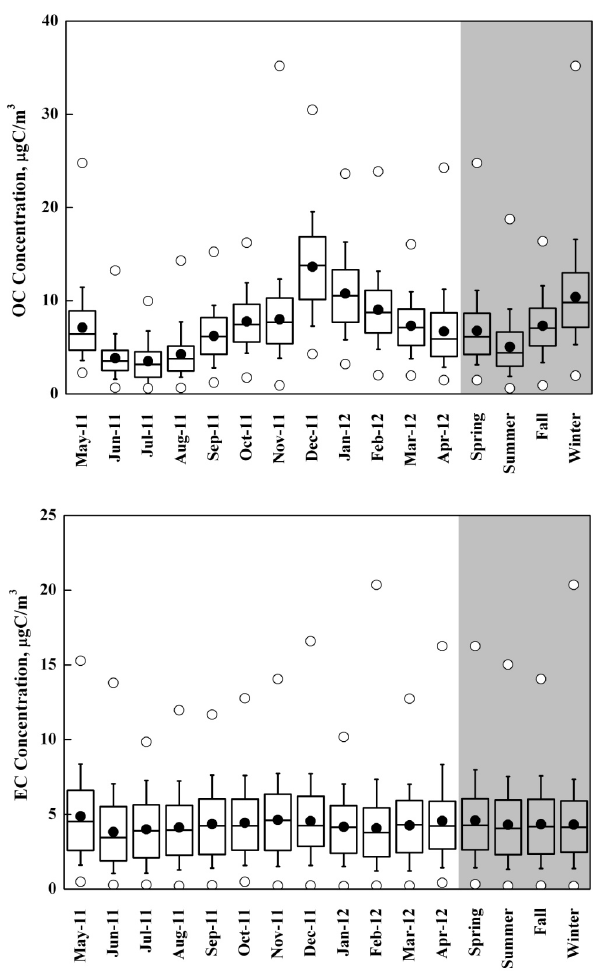
Figure 2 . The 1-hr OC and EC concentrations in individual sampling months and in different Figure 2. The 1h OC and EC concentrations in individual sampling months and in different seasons at MK AQMS during the study pe- seasons at MK AQMS during the study period from May 2011 to April 2012 (The box length: riod from May 2011 to April 2012 (Bottom and top of box: the 25th the 25 th and the 75 th percentiles; the whiskers: the 10 th and the 90 th percentiles; the dot in the and the 75th percentiles; whiskers: the 10th and 90th percentiles; box: the average; the line in the box: the median; the circles: the minimum and maximum dot in the box: the average; line in the box: the median; white cir- cles: the minimum and maximum values).